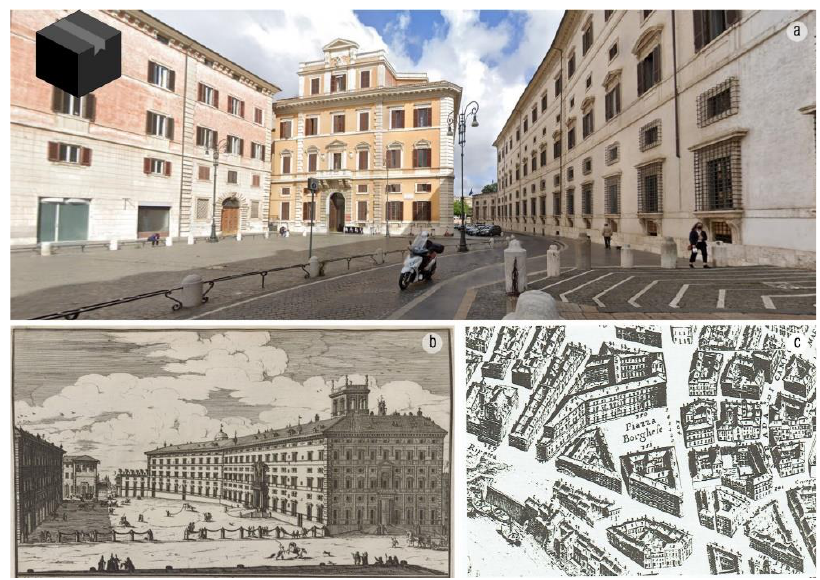
Figure 1. ( a ) The building in Piazza Borghese in its current state. ( b ) Piazza Borghese as represented in a G. B. Falda drawing, 1943. ( c ) Piazza Borghese in a planimetric view of Rome, made by Giuseppe Vasi in 1676.